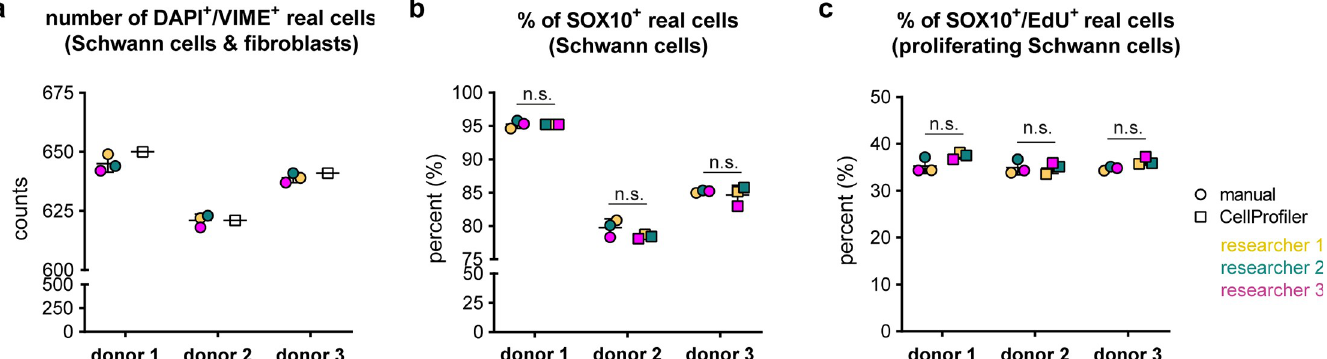
Fig 3. Comparison of CellProfiler and manual counting results. The diagrams show the calculated (a) numbers of DAPI + /VIME + real cells , (b) percentages of SOX10 + real cells (= SC culture purity) and (c) percentage of SOX10 + /EdU + real cells (= proliferating SCs) obtained by either manual counting (circles) or the CellProfiler pipeline (squares) ± SD in 3 donors; n.s. ... not